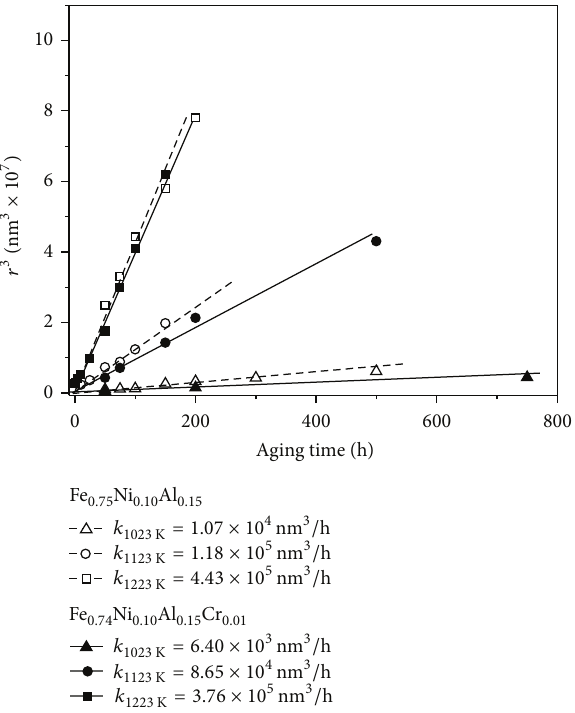
Figure 4: Plot of 𝑟 3 value for precipitates against aging time for the aged Fe 0.75 Ni 0.10 Al 0.15 and Fe 0.74 Ni 0.10 Al 0.15 Cr 0.01 alloys.